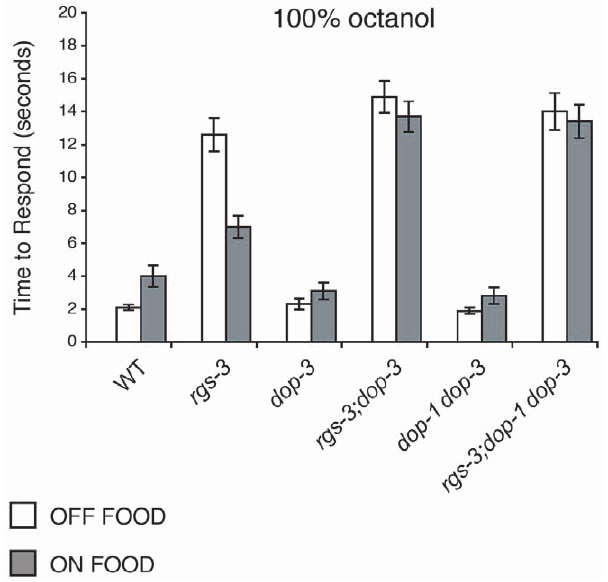
Figure 2. DOP-1 does not antagonize DOP-3 in octanol avoidance. Previous studies showed that DOP-1 can antagonize DOP-3 in cholinergic motor neurons [25]. However, loss of DOP-1 function had no effect on the avoidance of 100% octanol when examined in combination with loss of DOP-3 function. The ‘‘on food’’ response of rgs-3;dop-3 animals was indistinguishable from that of rgs- 3;dop-1dop-3 (p . 0.5). Alleles used: rgs-3(vs19) , dop-1(vs100) and dop- 3(vs106) . WT = the N2 wild-type strain. The time to respond is shown. n $ 40. Error bars represent the standard error of the mean (SEM).